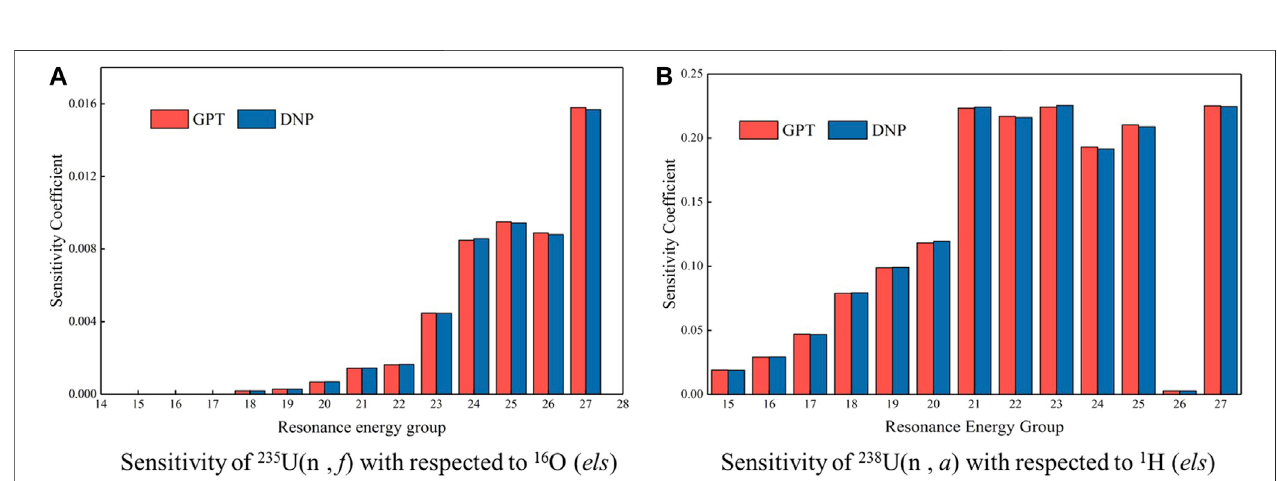
FIGURE 5 | Comparisons of implicit sensitivity coef fi cients for non-resonance nuclides.